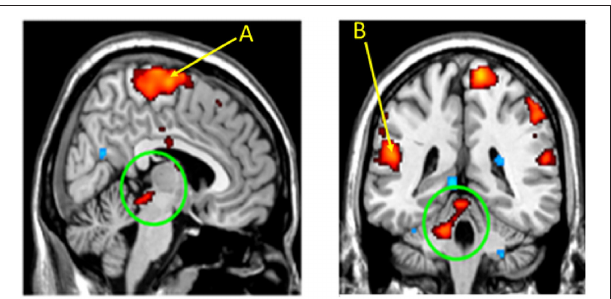
FIGURE 1 | Cerebellar and parabrachial pontine nuclei are activated by limb proprioceptive sensory stimulation. Functional MRI images following passive right foot movement in 14 children activated the parabrachial pons (Left circled area) and medial cerebellum (right circled area), sites involved in respiratory timing and blood pressure control. The sensorimotor cortex for the foot (A) and for the cervical region (for diaphragm), (B) are also activated, indicating that locomotion (foot) and breathing motor sites are concurrently recruited by the proprioceptive stimuli. From